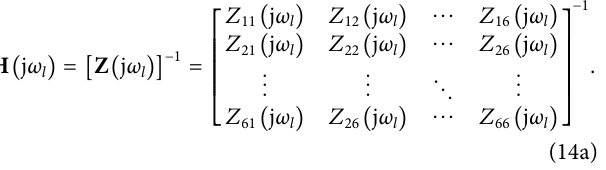
Frontiers in Energy Research |